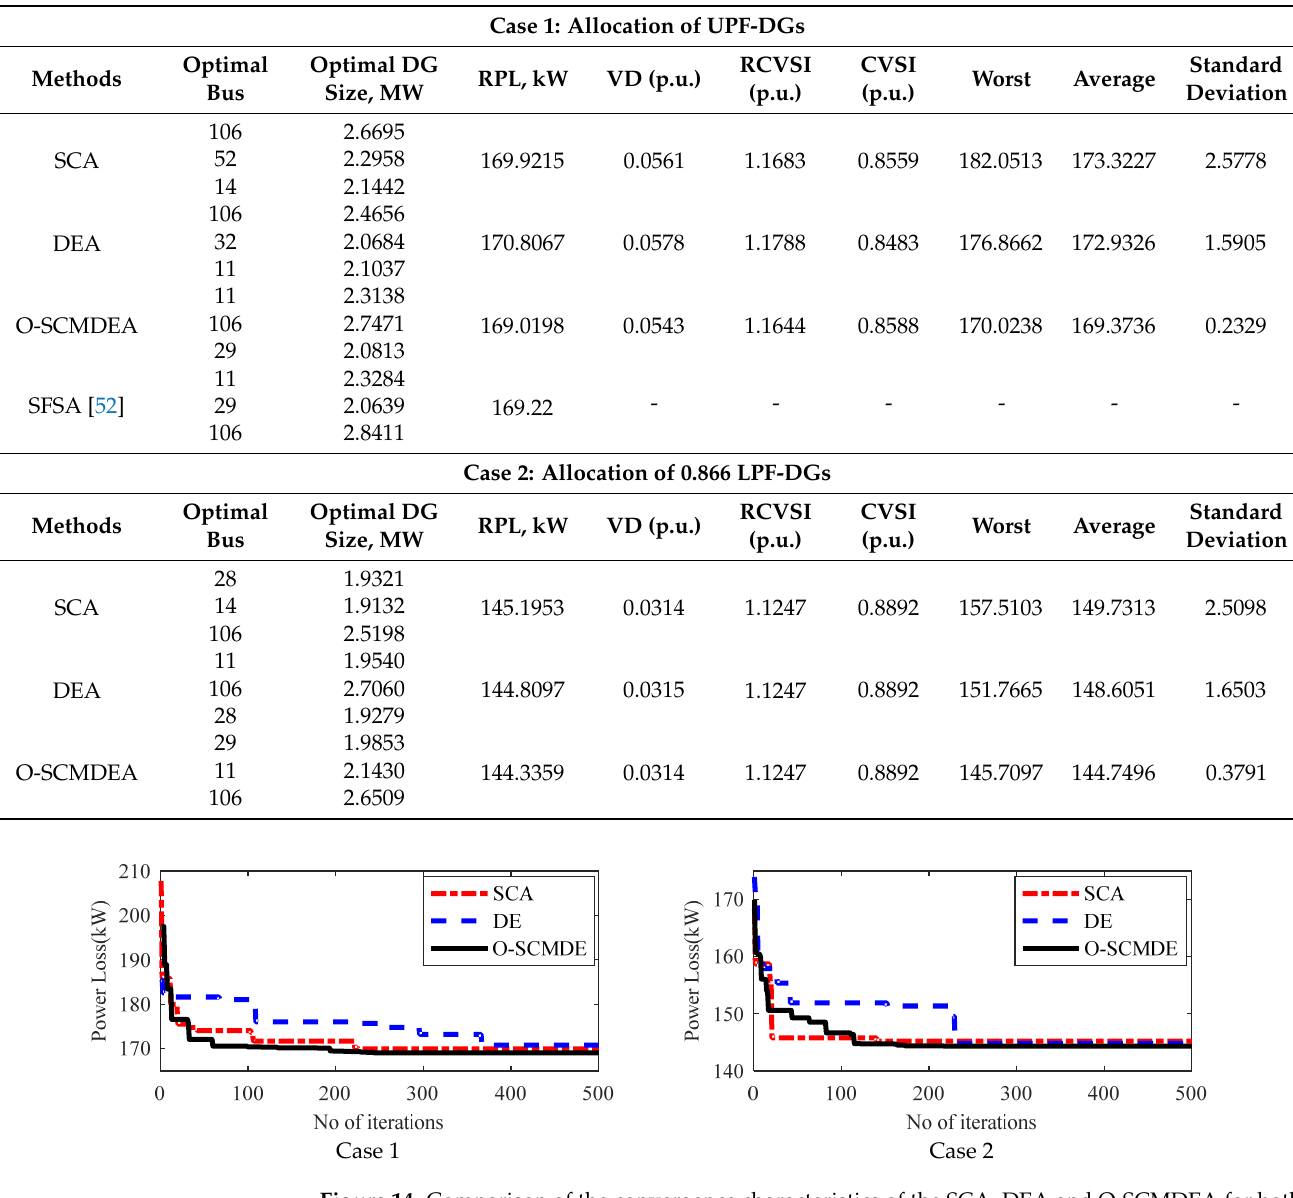
Figure 14. Comparison of the convergence characteristics of the SCA, DEA and O-SCMDEA for both cases of scenario I of the 136 bus system.